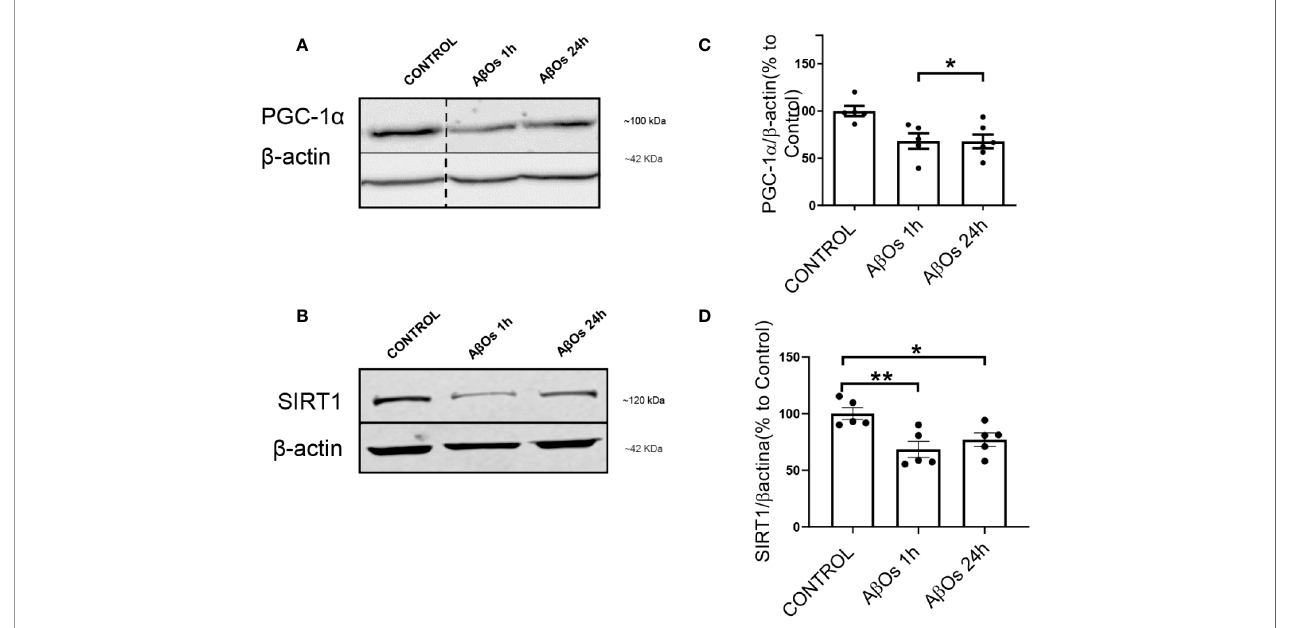
FIGURE 6 | Changes in SIRT1 and PGC-1 a levels after exposure to A b Os. (A) PGC-1 a western blot of PC12 lysates control and treated with A b Os (0.5 m M) for 1 and 24 h. (B) SIRT1 western blot of PC12 lysates in the same conditions as A. (C) Quanti fi cation of PGC-1 a protein levels normalized to b actin levels, and (D) SIRT1 protein levels under similar conditions as C. Data are represented as mean ± SEM. *p < 0.0, **p < 0.01, compared between the control group. One-way ANOVA with the Dunn's multiple comparisons test was used for all statistical analyses. PGC-1, Peroxisome proliferator-activated receptor gamma coactivator 1- alpha; SIRT1, silent information regulator 2 homolog 1. (n=5 – 6/group). A dotted line on the western blot indicates different regions of the same gel (original gel blot are provided on Supplementary Figure 6